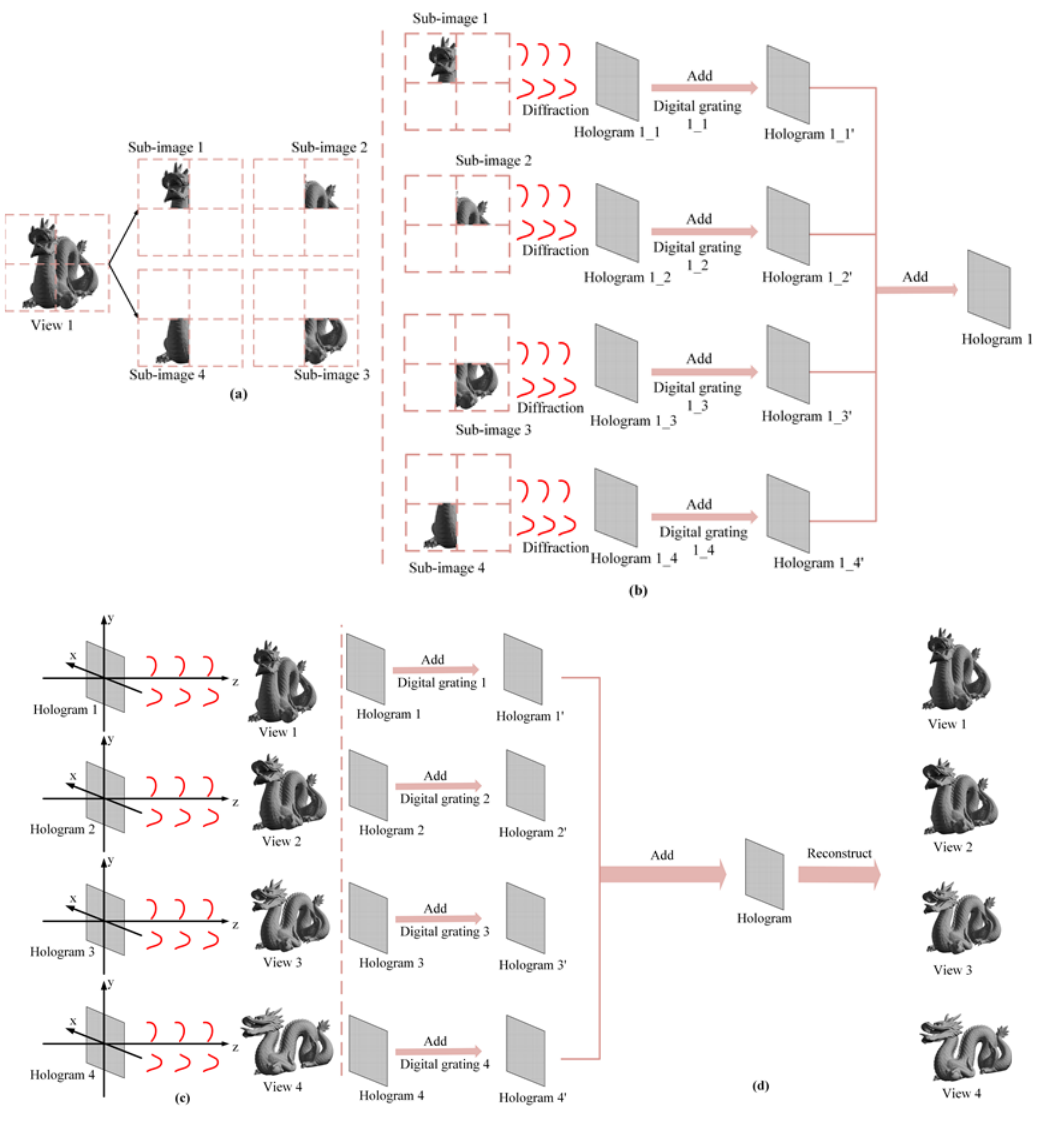
Figure 4. The schematic diagram of the synthetic hologram generation process. ( a ) the separation process of sub-images for view 1 ( b ) the generation process of hologram for view 1 ( c ) the Correspondence between holograms and viewpoints ( d ) the generation process for the synthetic hologram